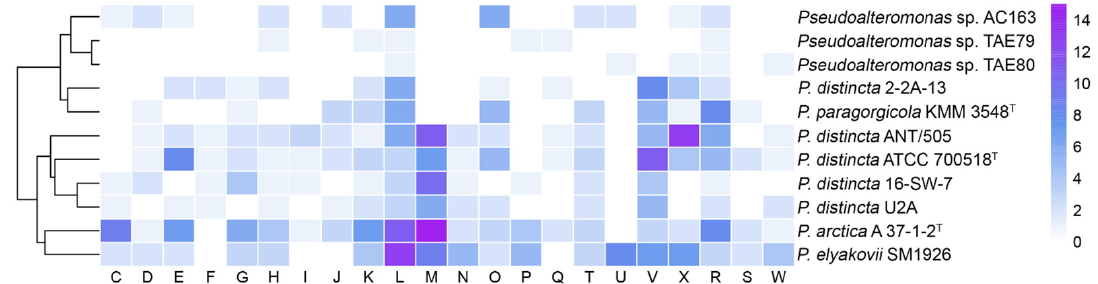
Figure 9. Functional annotation of unique genes among strains of P. distincta and P. arctica A 37-1-1 T (the P. distincta TB25 orthologues were mostly not found): Genes were assigned to the following COG categories: C, energy production and conversion; D, cell cycle control and mitosis; E, amino acid metabolism and transport; F, nucleotide metabolism and transport; G, carbohydrate metabolism and transport; H, coenzyme metabolism, I, lipid metabolism; J, translation; K, transcription; L, replication and repair; M, cell wall/membrane/envelope biogenesis; N, cell motility; O, post-translational modification, protein turnover, chaperone functions; P, inorganic ion transport and metabolism; Q, secondary structure; T, signal transduction; U, intracellular trafficking and secretion; V, defense mechanisms; X, mobilome: prophages, transposons; R, general functional prediction only; S, function unknown; W, extracellular structures.